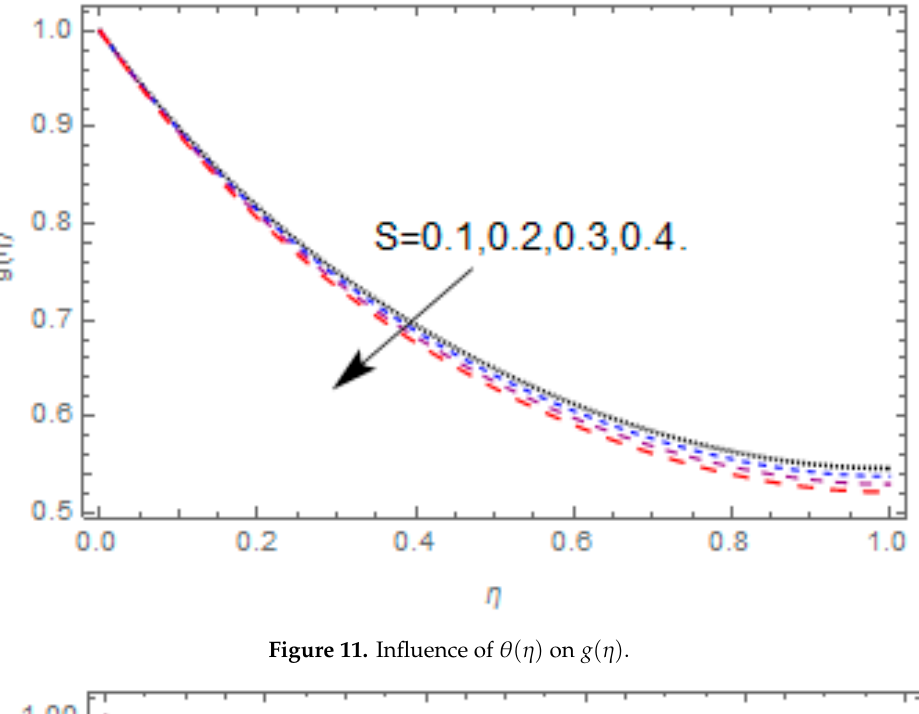
Figure 10. Influence of ( ) S on ( ) f